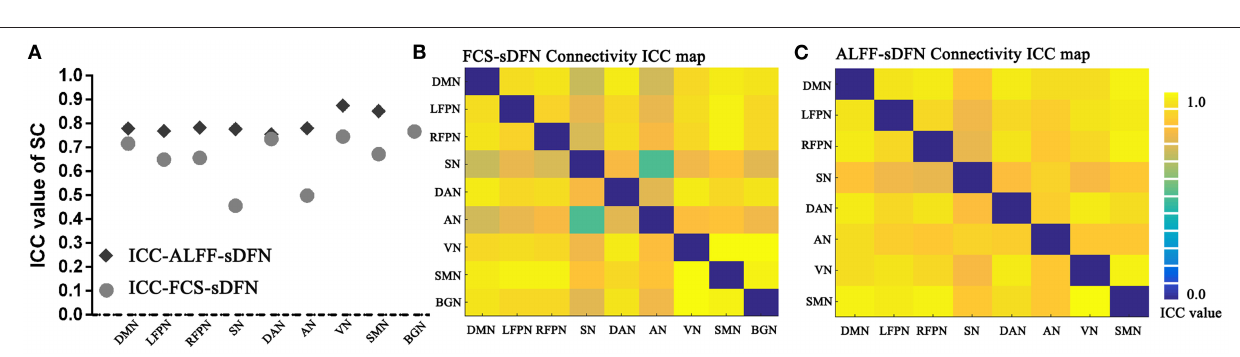
FIGURE 6 | Intra-class correlation (ICC) maps of spatial correlation (SC) and connectivity between sDFN across a range of window sizes in subjects. (A) Shows the ICC values of SC, including SC of FCS-sDFN and SC of ALFF-sDFN. (B) Denotes the ICC values of connectivity between FCS-sDFN. (C) Denotes the ICC values of connectivity between